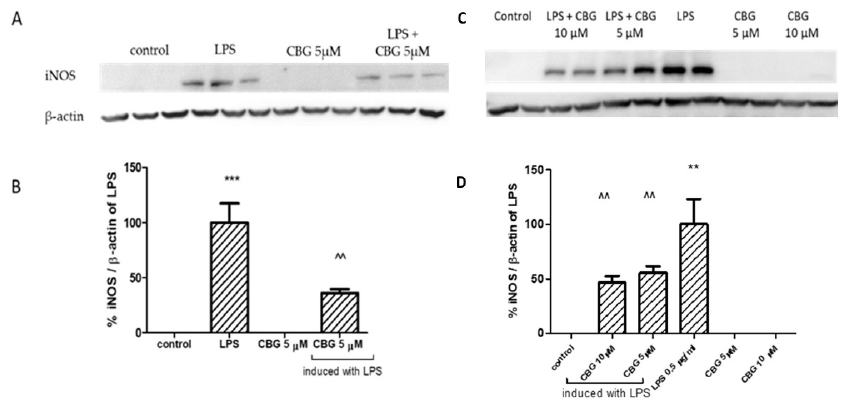
Figure 4. CBG decreased iNOS expression in LPS-induced BV2 microglia ( A,B ) and primary rat glial cells ( C,D ). Immunodection of iNOS with or without induction of LPS (7 ng/mL) in the presence or absence of CBG (5 µM) for BV2 ( A,B ) and with or without induction of LPS (0.5 µg/mL) in the presence or absence of CBG (5 and 10 µM) for primary rat glial cells ( C,D ). Forty (40) µg of protein from whole cell lysate was loaded on 7.5% polyacrylamide-SDS gels and blotted on a nitrocellulose membrane. Protein quantities were normalized to β -actin levels. Analysis of iNOS was performed using antibodies against iNOS (130 kDa) and β -actin (40 kDa). Band intensity analysis was performed using ImageJ software. Results are representative of two independent experiments and are presented as means ± SEM (n = 4–6). *** p <0.001 vs. control; ** p <0.005 vs. control; ˆˆ p < 0.005 vs. LPS.